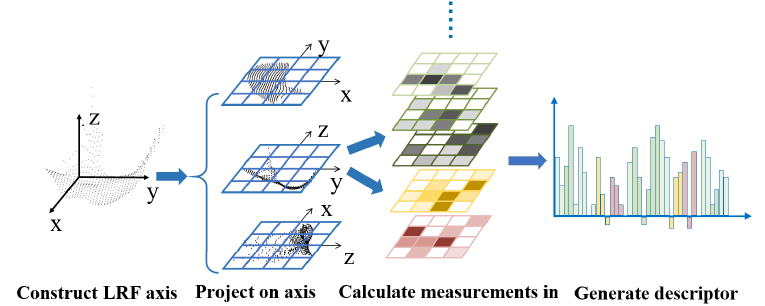
Figure 3. Establishment process of